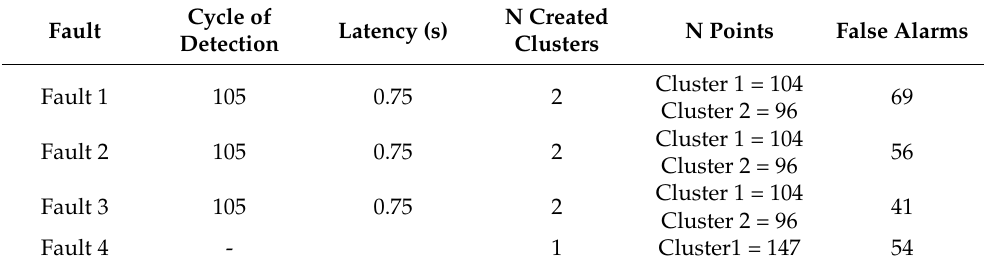
Figure 9. Results of the AAD + ADP algorithm applied to ( a ) features selected through the Pearson correlation analysis and ( b ) features extracted through the PCA (case packer). Table 5. Performances of the clustering-based from scratch approach (case packer).